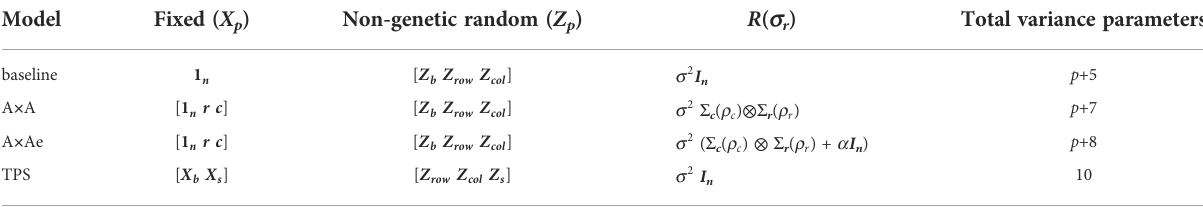
TABLE 1 Summary of the fi xed and non-genetic random terms, and the error variance structure in the A×A, A×Ae, TPS and baseline LMM.